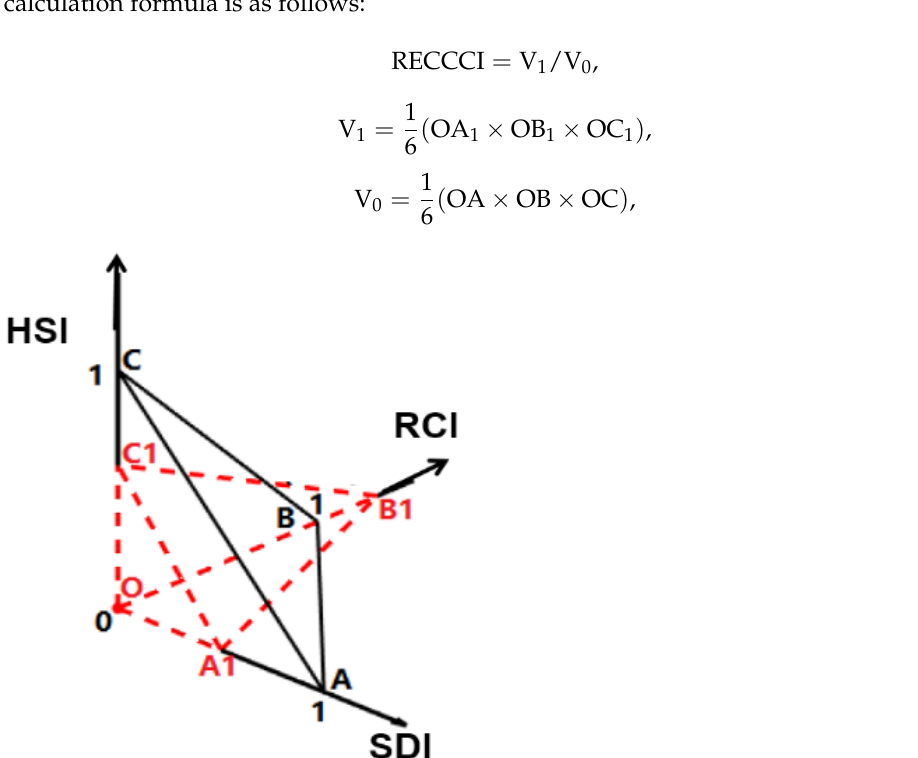
Figure 5. Schematic diagram of the resource environment comprehensive carrying capacity index (RECCI) model. HSI, human settlements index; RCI, resource carrying index; SDI, socio-economic development index.